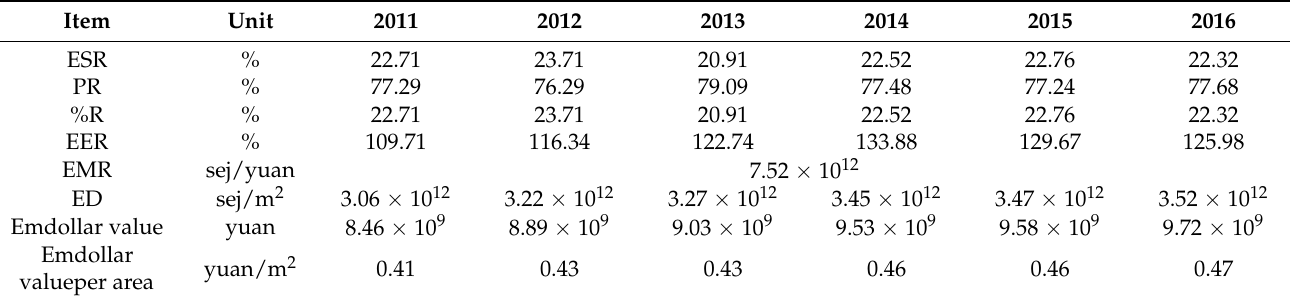
Table 5. Emergy indices of Zhoushan sea area during